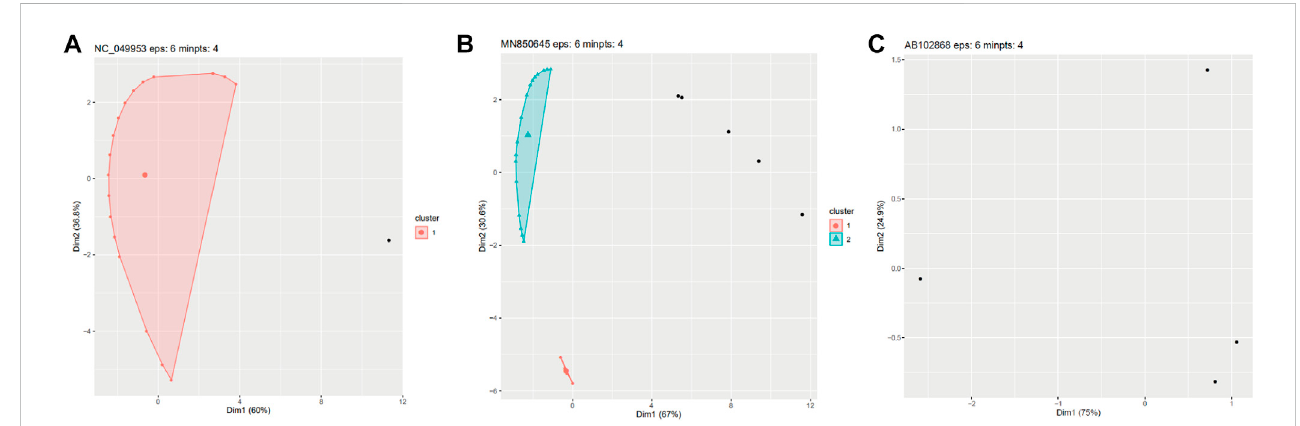
FIGURE 1 ThreeexamplesofclusteringusingtheDBSCANalgorithmwiththeparameters:Eps=6andminpts=4. (A) Alltailproteinsareclusteredintoonecluster. (B) Tail proteins are clustered into two clusters. (C) Proteins is too discrete to be clusters.